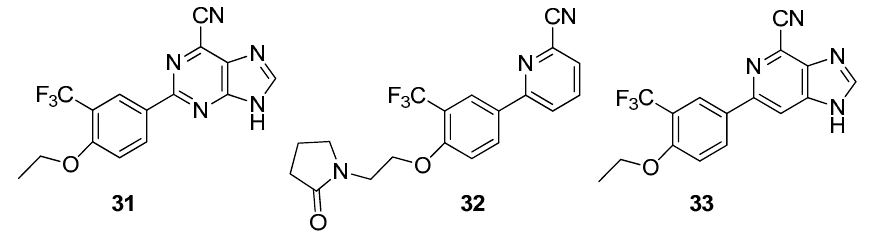
Figure 10. Anti-autoimmune azines 31 – 33 .